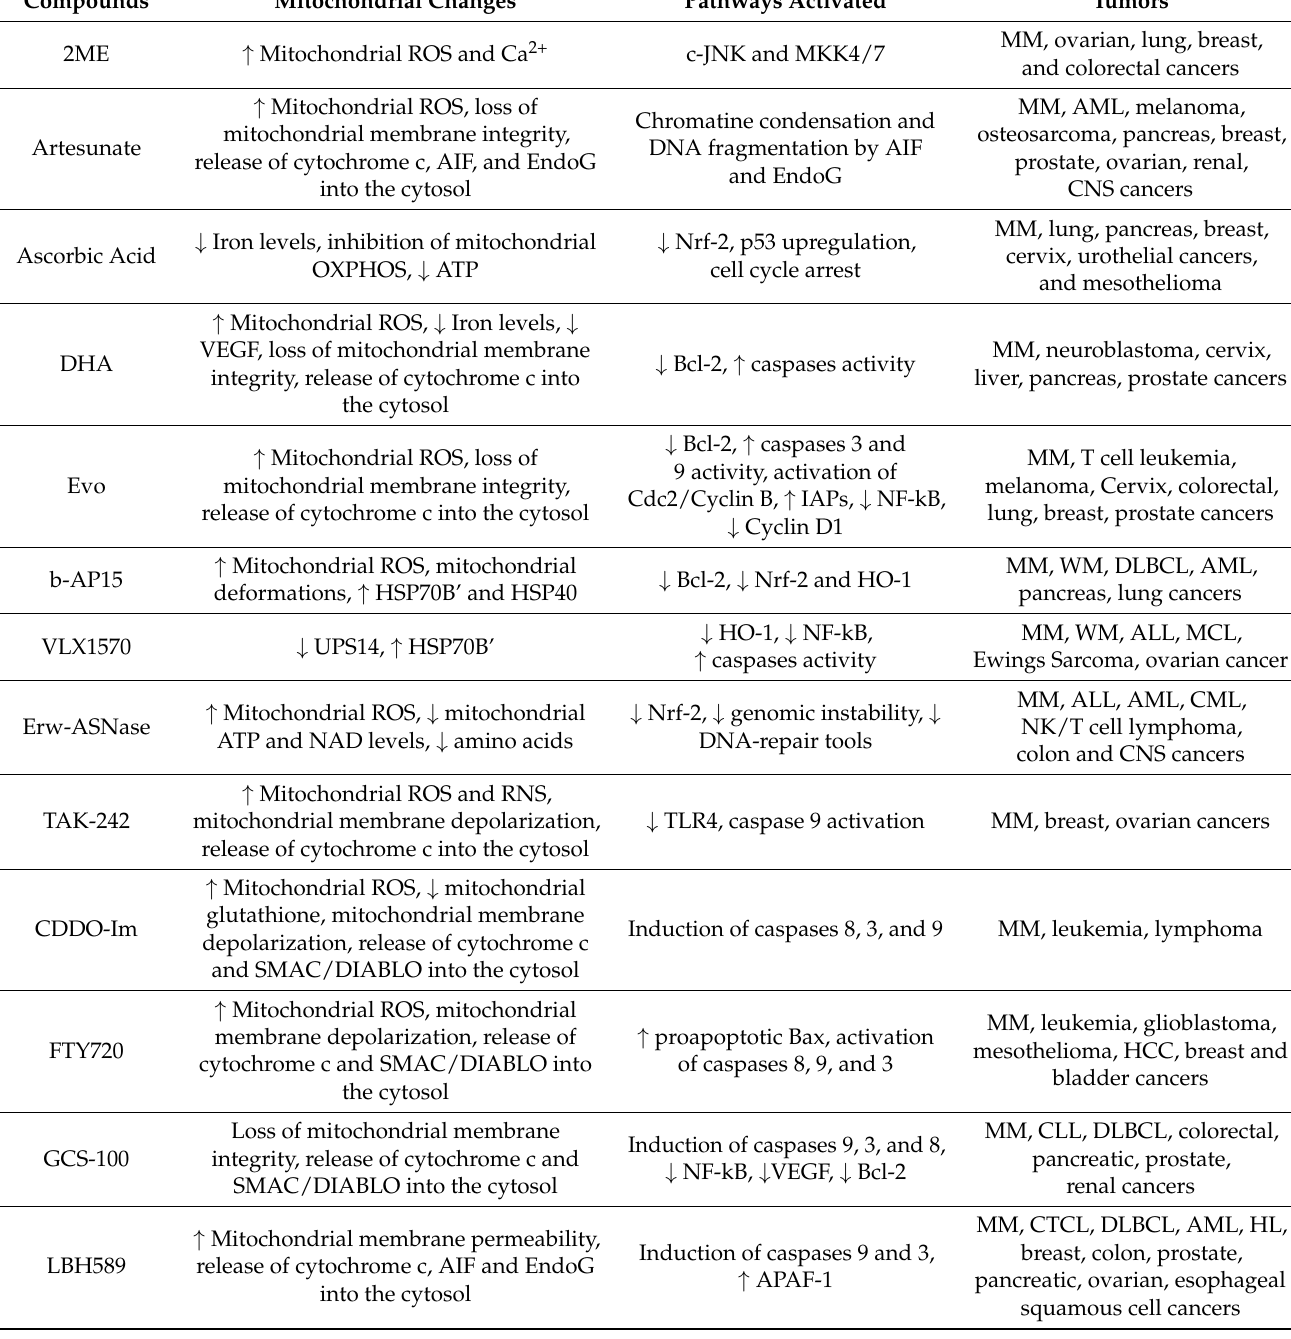
Table 1. Mechanisms of action and pathways activated by anti-mitochondrial